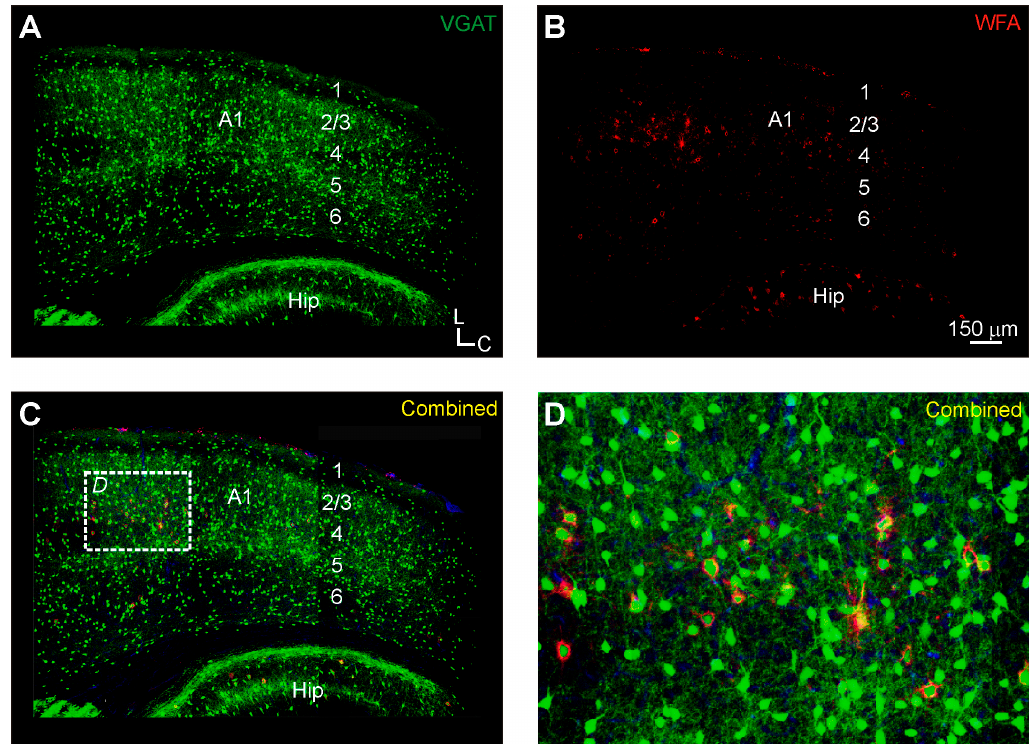
Figure 6. Perineuronal net (PNN) expression in the primary auditory cortex (A1) of vesicular gamma-amino butyric acid transporter (VGAT)-Venus C57BL/6 mice: ( A ) VGAT-Venus positive cell bodies and fibers (green) are found throughout all layers of the auditory cortex; ( B ) wisteria floribunda agglutinin (WFA)-labeled perineuronal nets (PNNs) were found scattered throughout the auditory cortex (A1), but were particularly dense in layer 4; and ( C – D ) these PNNs often surrounded the VGAT-Venus positive cell bodies, and appeared to be more highly expressed in the rostral portions of the primary auditory cortex. Panel D is magnified from boxed region in Panel C. A1, primary auditory cortex; Hip, hippocampus; 1–6, cortical layers 1–6.